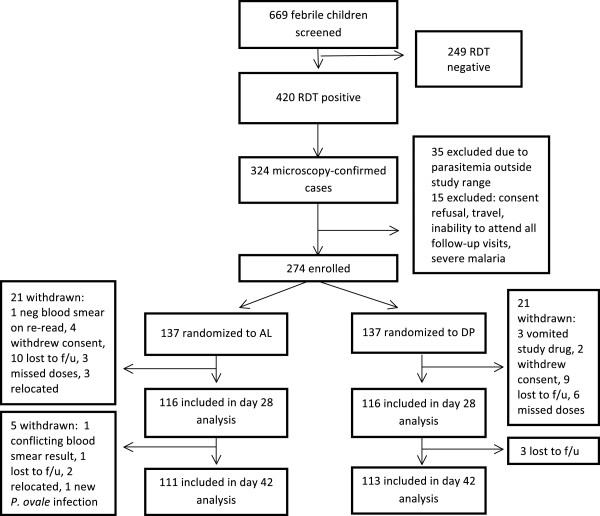
Trial profile, western Kenya, 2011. Legend: RDT: Rapid diagnostic test for malaria; f/u: follow up; neg: negative.